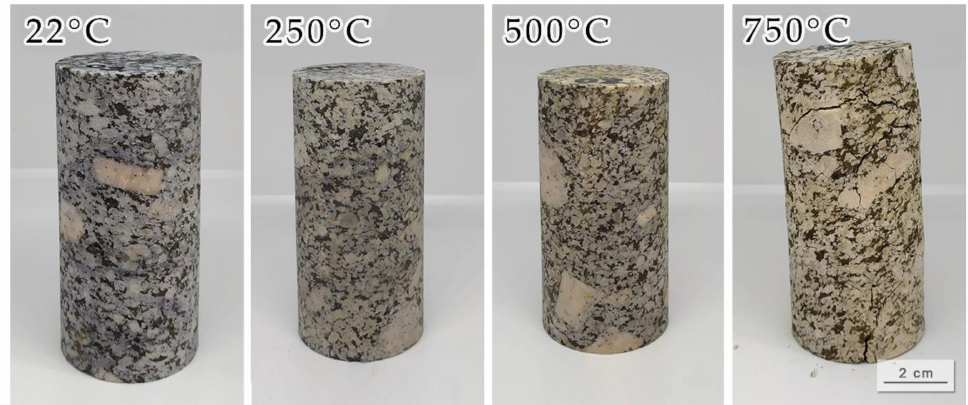
Figure 2. Cylindrical samples are showing color changes from 22 ◦ C, 250 ◦ C, 500 ◦ C, and 750 ◦ C. Note the macro cracks in sample 750 ◦